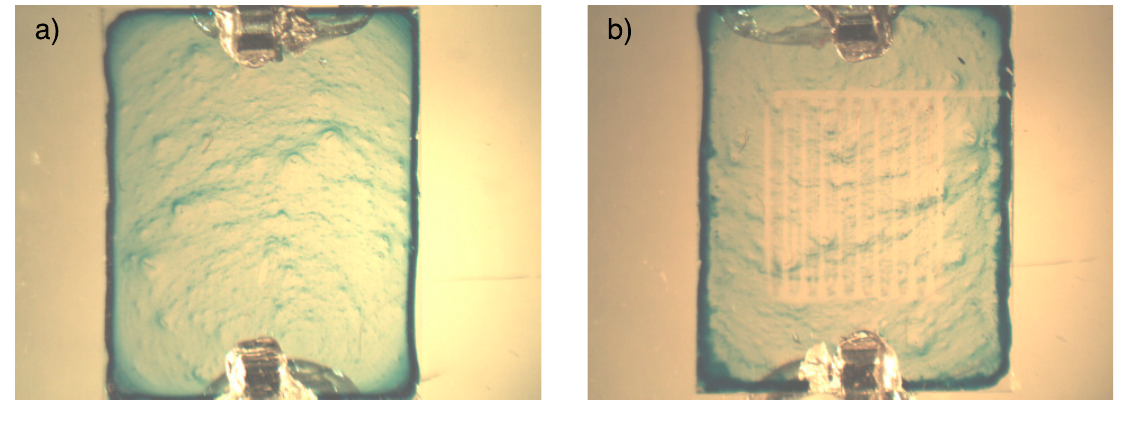
Figure 4. PVP resistor before humidity exposure ( a ); and after humidity exposure ( b ).